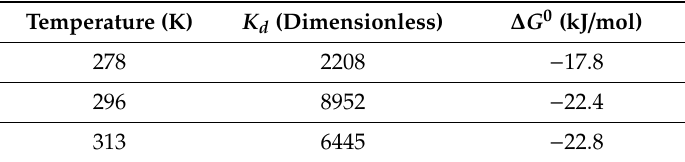
Table 3. K d and ∆ G 0 values for adsorption of Doxycycline onto UiO-66 at di ff erent temperatures.